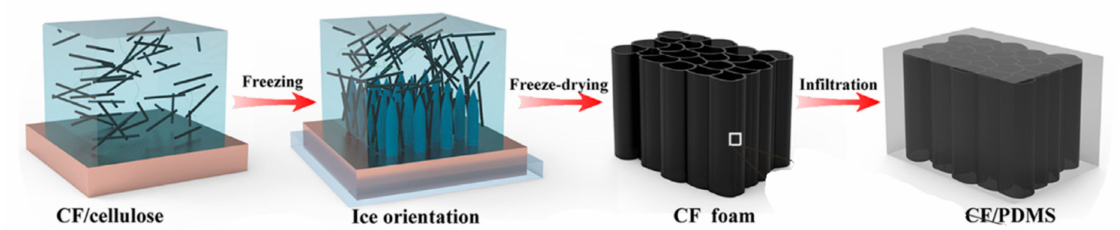
Figure 4. Schematic diagram for demonstrating the preparation process of the freeze-drying method for synthesizing orientated CF composite. Reprinted with permission from [8]. Copyright 2019 Elsevier